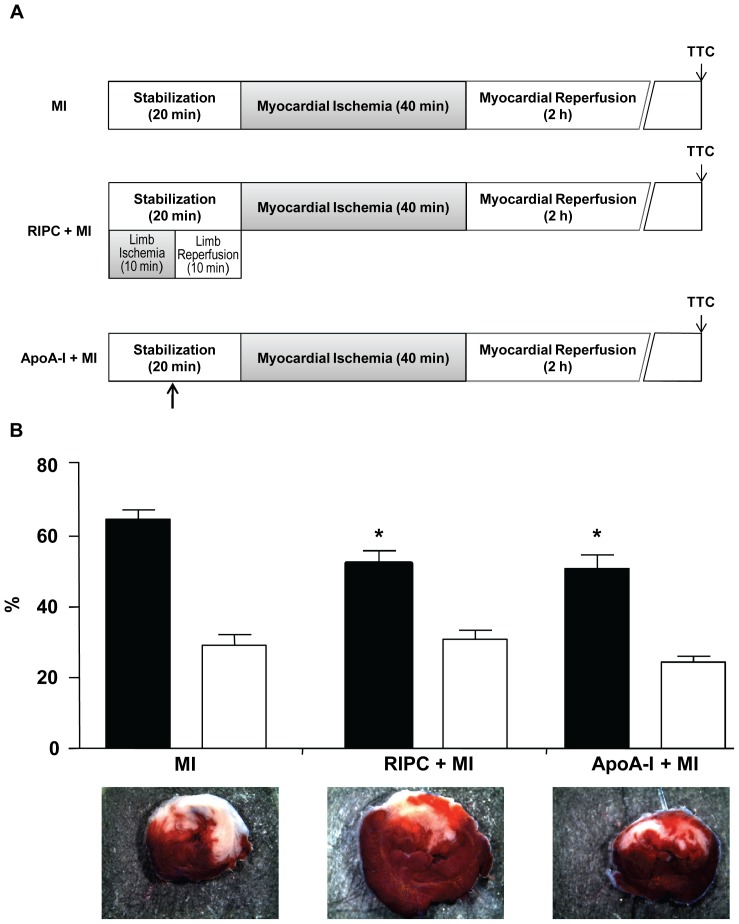
ApoA-I reduces infarcted area in rats submitted to ischaemia-reperfusion protocol.(A) Experimental protocol. All groups were subjected to 40-minute coronary occlusion followed by 2-hour reperfusion. RIPC was achieved by 10-minute limb ischemia followed by 10-minute reperfusion. ApoA-I (10 mg/kg) was administered 10 minutes before coronary artery occlusion (arrow). (B) Representative pictures of mid- ventricular 2,3,5-triphenyltetrazolium chloride-stained sections and bar graph showing infarct size expressed as a percentage of area at risk (black bars), and area at risk as a percentage of total left ventricular area (white bars). Results are given as mean ±SEM. *p<0.05 vs. MI group, n = 8–11 in each group.